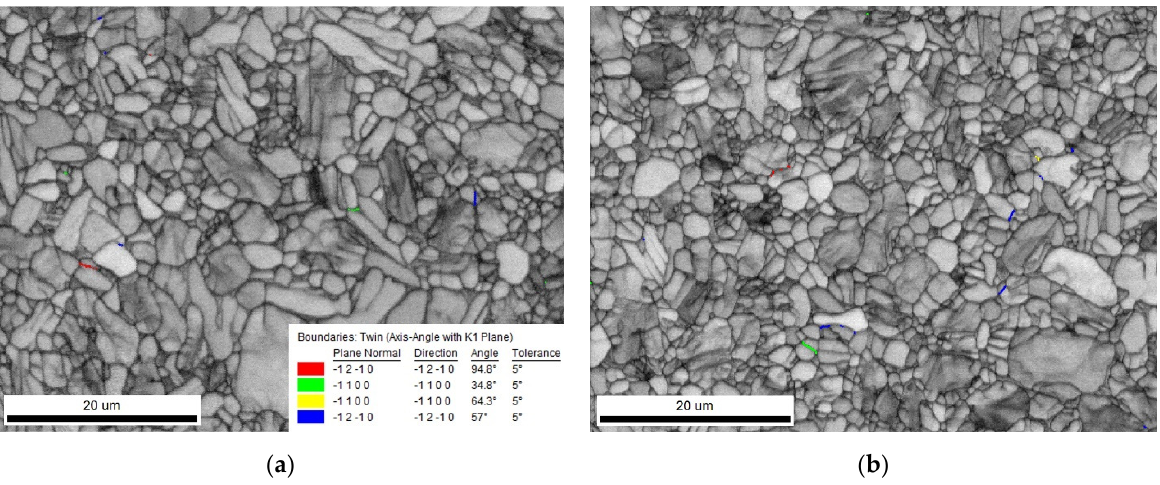
Figure 14. Pole figures of the Ti-6Al-4V surface under different milling parameters. ( a ) Sample 1. ( b ) Sample